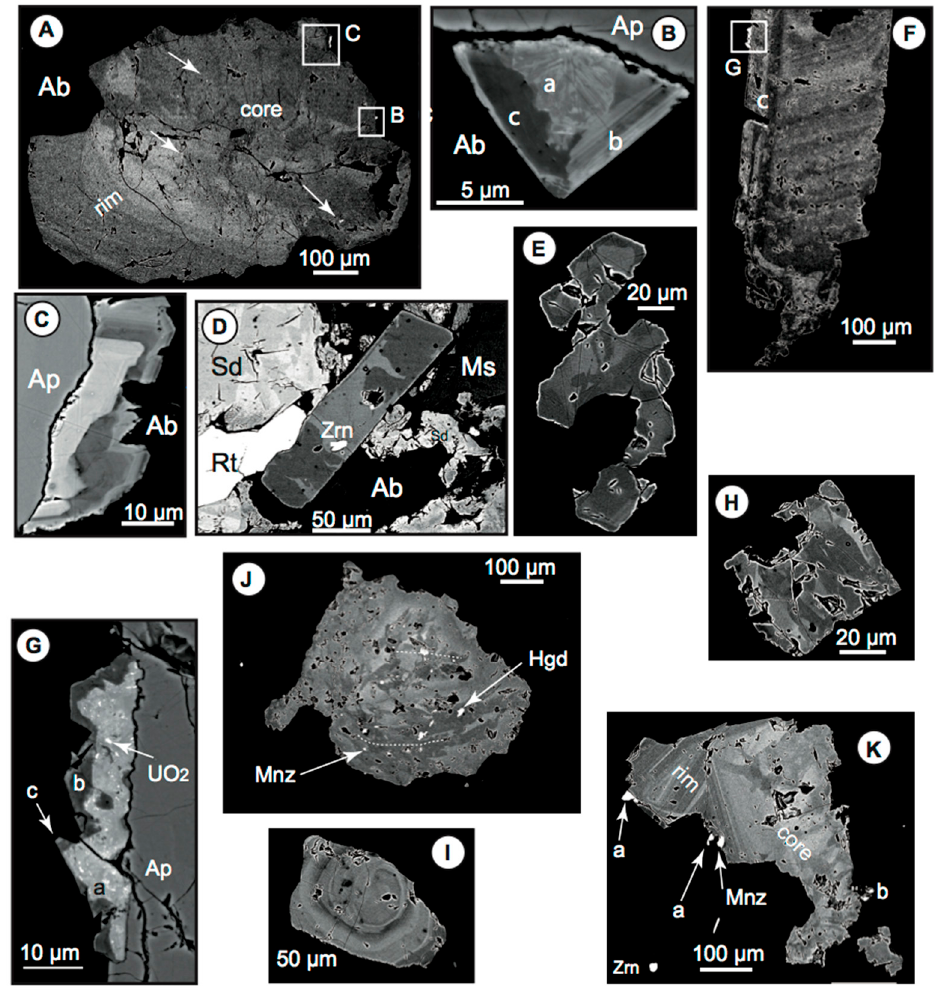
Figure 14. Apatite in granites of the G1 suite in the SCB2 drill-hole (SEM-BSE images). ( A–C ) Largely zoned apatite embedded in an albite aureole within a perthitic Kfs from the G1a granite (sample PAN-16-5b, see Figure 10). ( A ) Overview of the crystal, showing a core with inclusions of uraninite, monazite, and Al–Fe–Mn phosphate (arrows), which is corroded/surrounded by a rim with oscillatory zoning (OZ). ( B ) Overgrowth of an alumina-phosphate-sulfate (APS) assemblage; a: fibrous solid solution goyazite-florencite, b: metal-poor sector of a sector zoned crystal, formed by goyazite, c: metal-rich sector, formed by a solid solution goyazite-florencite (OZ is due to variations in Sr and LREE contents). ( C ) Overgrowth of zoned siderite, marked by Mg variations. ( D ) A patchy zoned crystal within an alteration assemblage at the expense of a protolithionite (granite G1a, sample PAN-16-5b). ( E ) Chain of small patchy zoned crystals embedded in an albite crystal included in Kfs (granite G1a, sample PAN-16-6). ( F ) A complexly zoned crystal with an APS overgrowth ( G ) (granite G1b, sample PAN-16-4a). ( G ) Detail of ( F ), showing the APS overgrowth on the apatite; a and c: solid solution goyazite-florencite, b: goyazite; note the numerous uraninite micro-inclusions in a. ( H ) Patchy zoned crystal included in muscovite (granite G1c, sample PAN-16-3a). ( I ) Small zoned crystal (OZ) in the G1c unit (sample PAN-16-4b). ( J ) Large zoned crystal in the G1c unit (sample PAN-16-3b); a patchy core is dotted by micro-inclusions of monazite (Mnz) and hagendorfite (Hgd), with Hgd concentrated in a central domain (dashed line separation). ( K ) Large zoned crystal, included in an albite phenocryst invaded by quartz and muscovite (granite G1c, sample PAN-16-3b); a patchy core is surrounded by a zoned rim (OZ). Overgrowth of monazite (Mnz) and APS in the rim, and the core free of inclusions; a: solid solution goyazite-florencite; b: APS succession and uraninite inclusions as in ( G ).